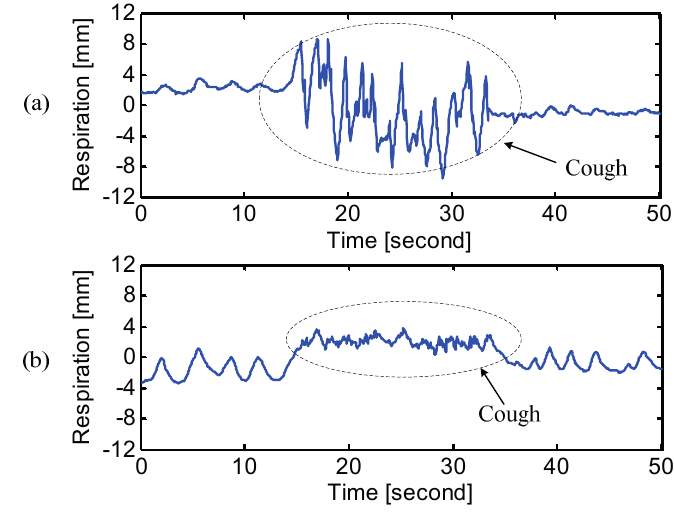
Figure 9. Radar measured respiration pattern of “cough” at ( a ) chest and ( b )